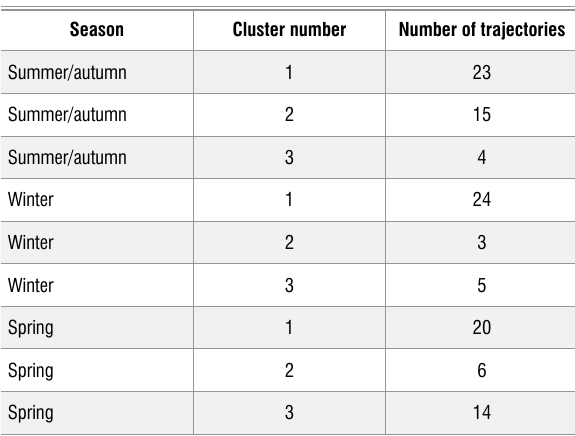
Cluster means and their trajectories for summer/autumn, winter and spring